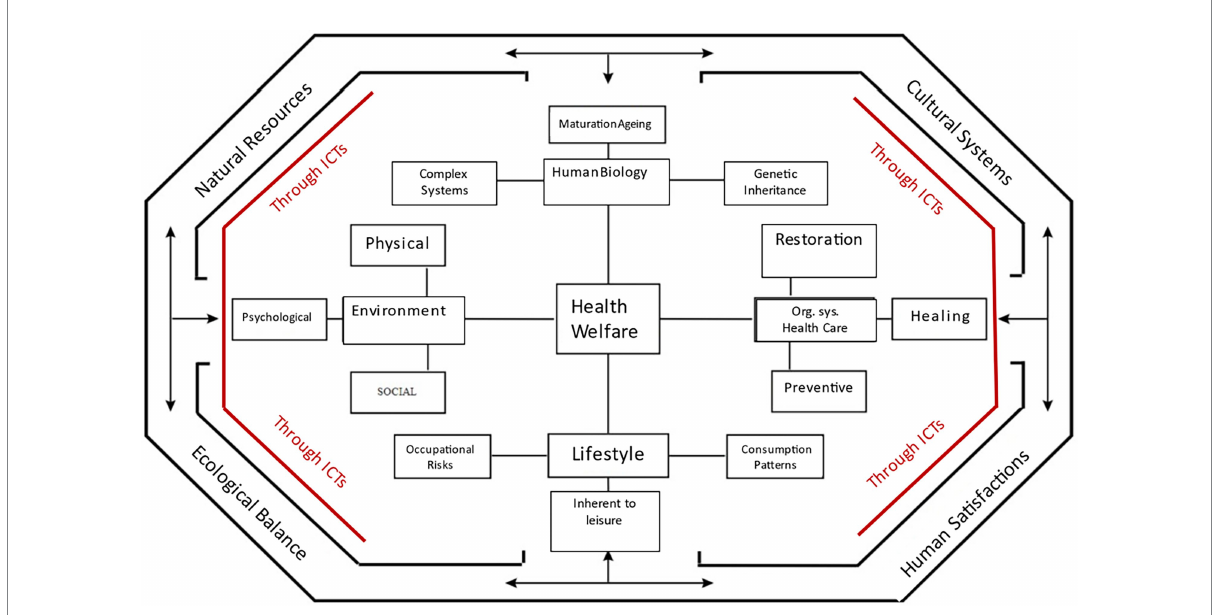
FIGURE 1 Epidemiological model for health field analysis in health promotion, preservation, and recovery. Modified by the author from: Dever (1976), Blum (1981), and Coutino et al.